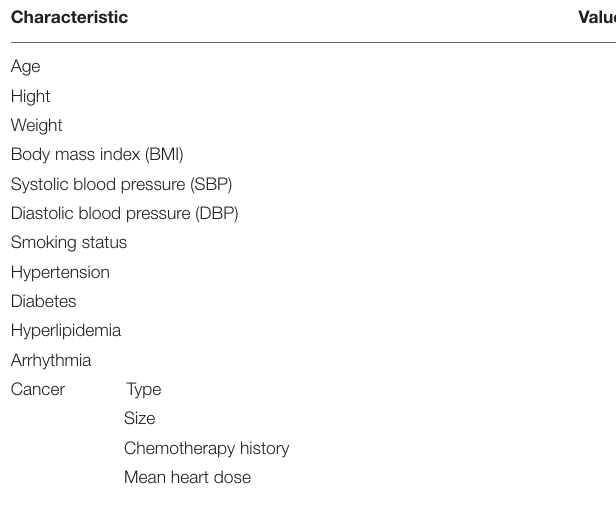
TABLE 2 | Baseline